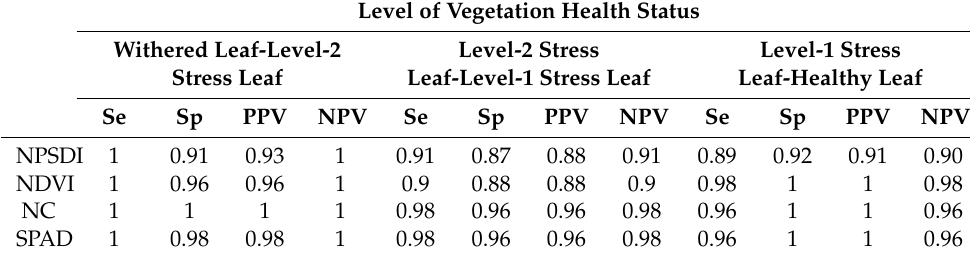
Table 1. Discrimination accuracy between different grades of the plant health states obtained with the NDVI, NPSDI, nitrogen content (NC) and